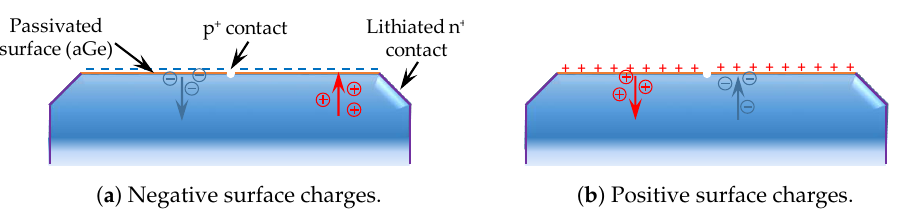
Figure 3. Effect of ( a ) negative and ( b ) positive charges on the passivated surface of a PPC germanium detector. In the case of negative (positive) surface charges, holes (electrons) are attracted to the surface, whereas electrons (holes) are repelled.